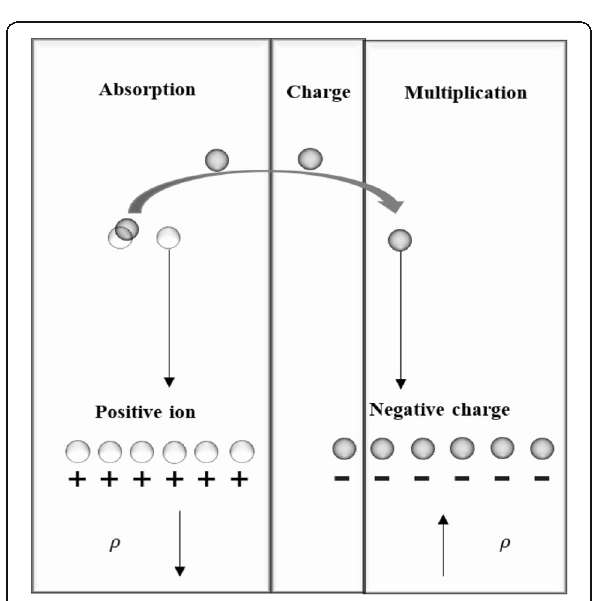
Fig. 4 Tunneling process and charge density change in the multiplication and absorption layers. Presents a schematic diagram of tunneling process in the device. If a sufficiently high electric field exists within the absorption layer, the local band bending may be sufficient to allow electrons to tunnel. When the absorption layer has a breakdown tunneling, the positive charge in absorption increases and the negative charge in the multiplication and charge layers increases. Thus, ρ is not equal to the dopant ion charge density in the depletion layer while the tunneling effect